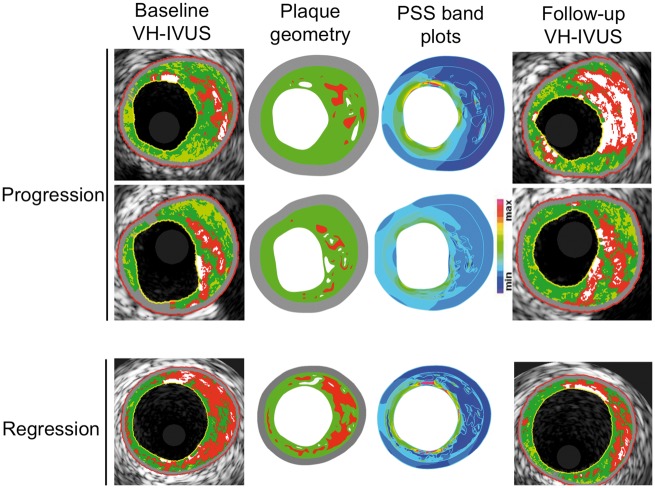
Illustrative examples for stepwise calculation of plaque structural stress from virtual-histology intravascular ultrasound through finite element analysis in areas of progression or regression. Baseline virtual-histology intravascular ultrasound images (left) showing necrotic core (red), dense calcium (white), fibrofatty tissue (light green), and fibrous (green), with associated reconstructed plaque geometry and segmented plaque components used for finite element analysis, and plaque structural stress band plots identifying regions with different stress concentration. Follow-up virtual-histology intravascular ultrasound images (right) show progression (upper and middle panels) or regression (lower panels). VH-IVUS, virtual-histology intravascular ultrasound.